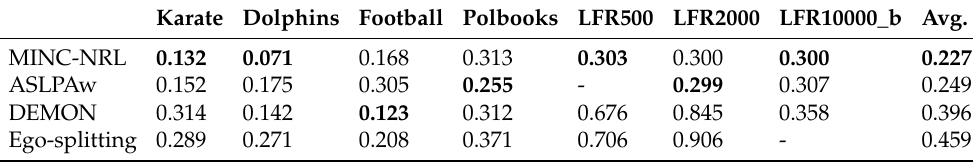
Table 9. AC of MINC-NRL compared with other